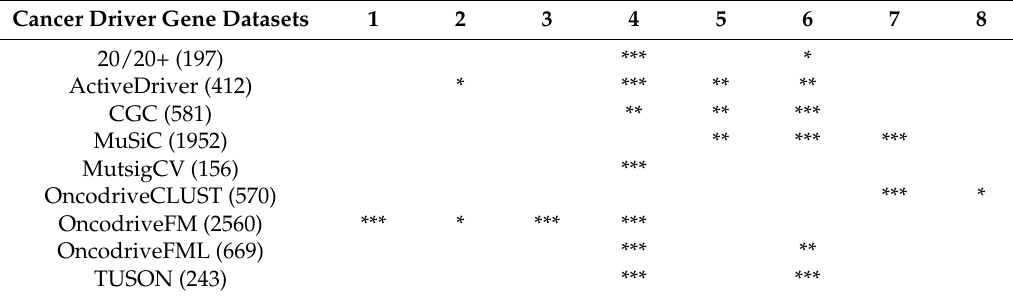
Table 1. Enrichment pattern of cancer driver